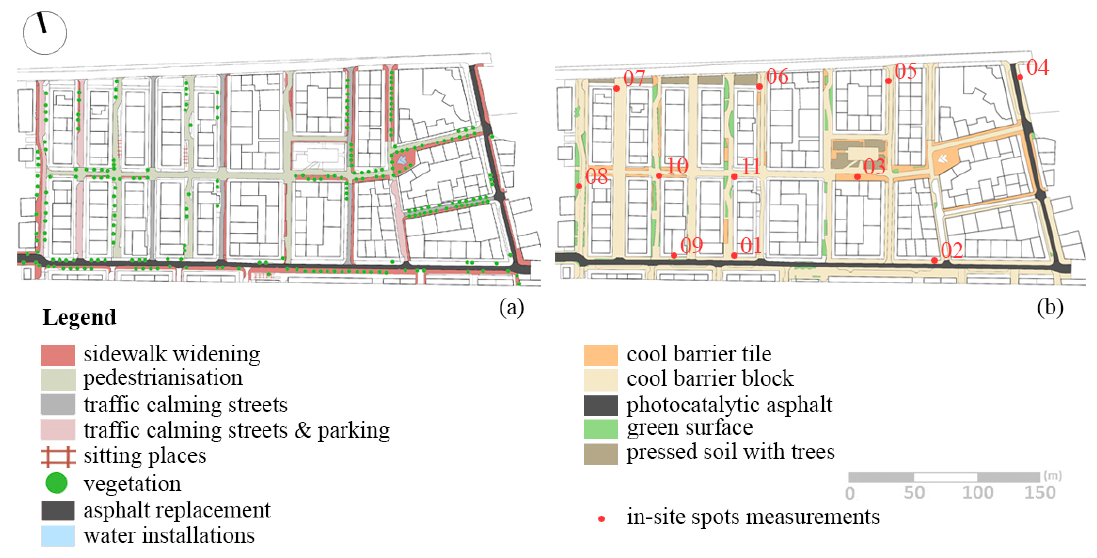
Figure 2. Urban redevelopment of the neighborhood Pavlou Mela: ( a ) Interventions, and ( b ) materials.